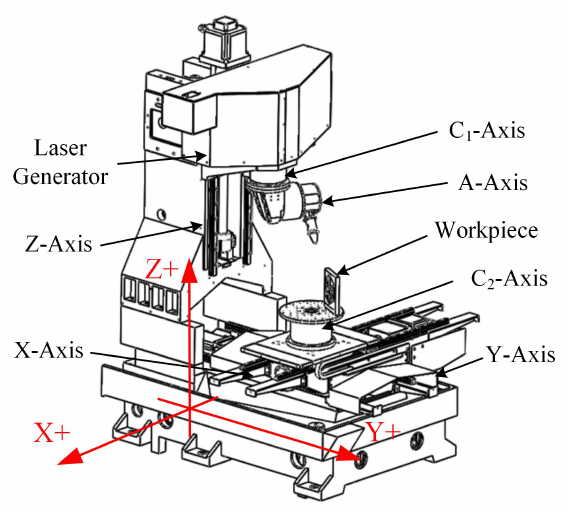
Figure 1. The structure of multi-axis